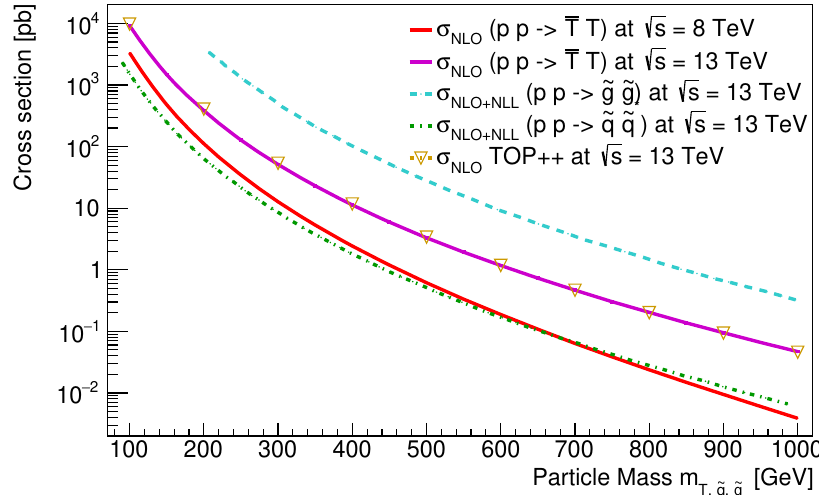
Figure 2. Next-to-leading order (NLO) pair production cross section for the top partner as a p function of m T at s = 8 ; 13 TeV. The cross section was computed using MadGraph5 at next-to- leading order by varying the top quark mass. The (cid:12)gure also contains the NLO top partner pair p production cross section at s = 13 TeV computed using TOP++2.0 program for a few benchmark points (triangles). Error bars from varying the renormalization and factorization scales are